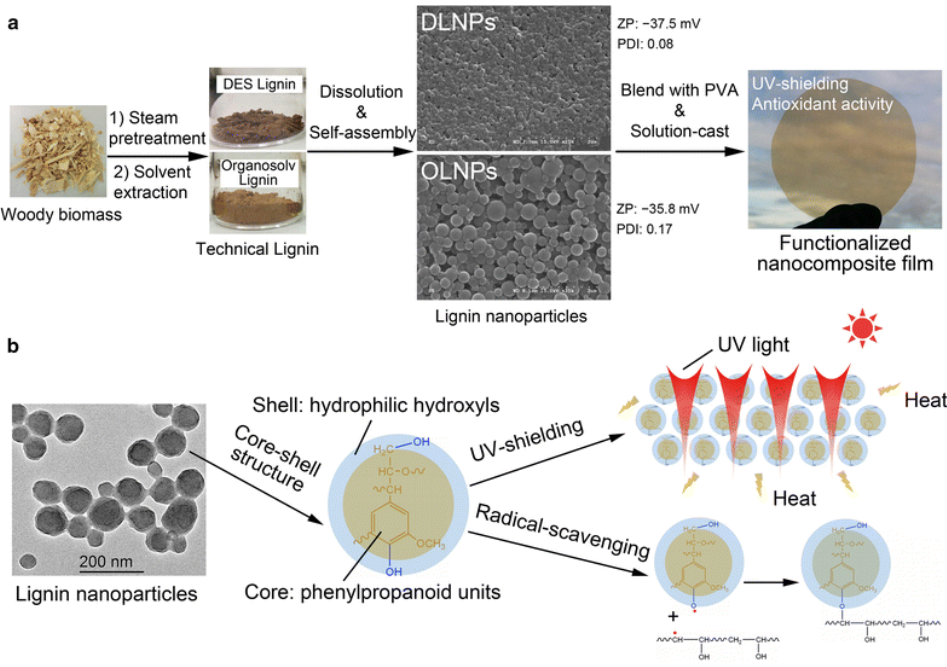
Figure 7. ( a ) Synthesis of lignin nanoparticles/PVA composite film. ( b ) Proposed mechanism for UV-shielding and antioxidant activity using lignin nanoparticles as the functional additive. Reprinted from Tian et al. [133].